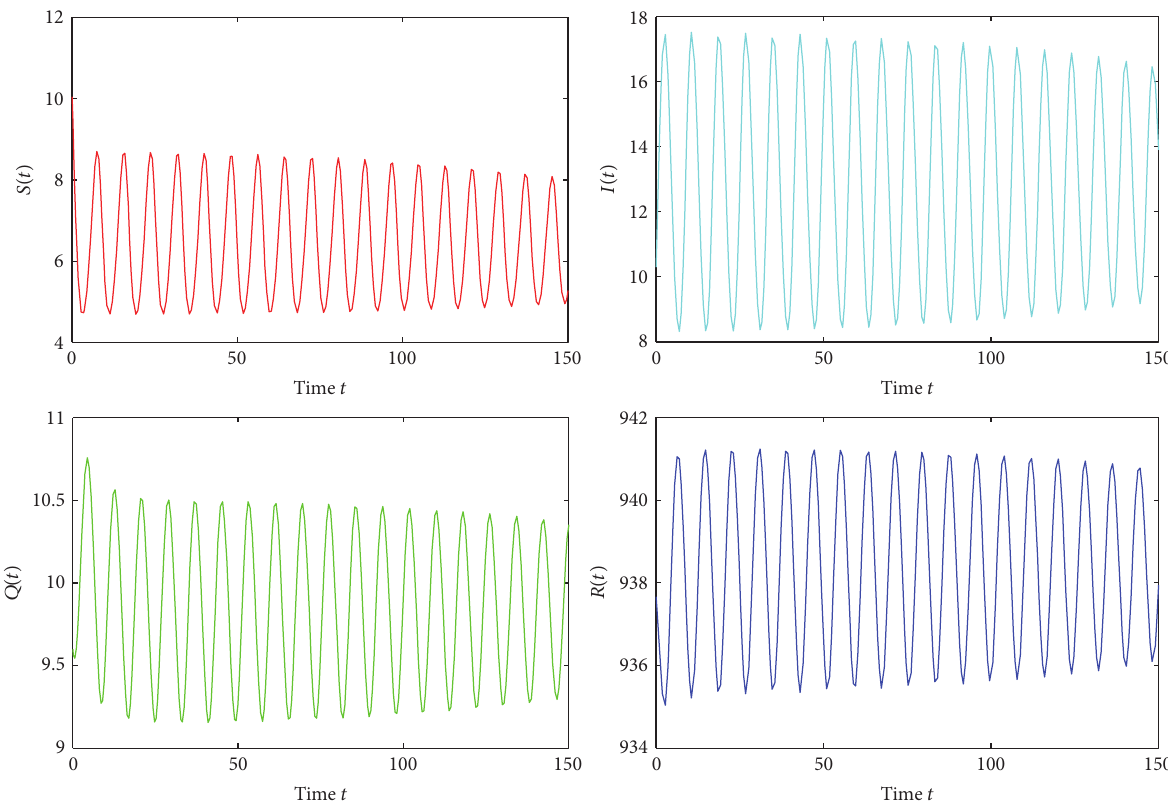
Figure 10: The trajectory of 𝑆 , 𝐼 , 𝑄 , and 𝑅 when 𝜏 2 = 1.8625 > 1.7852 = 𝜏 20 .